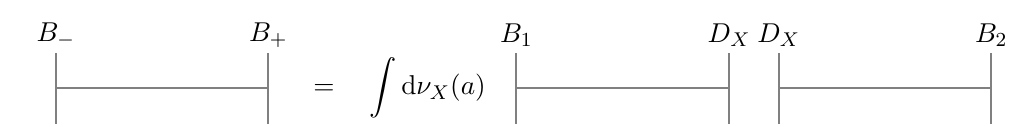
Figure 8 . The construction of a general correlation function integral and expressing the result in terms of the wave functions Z X;B